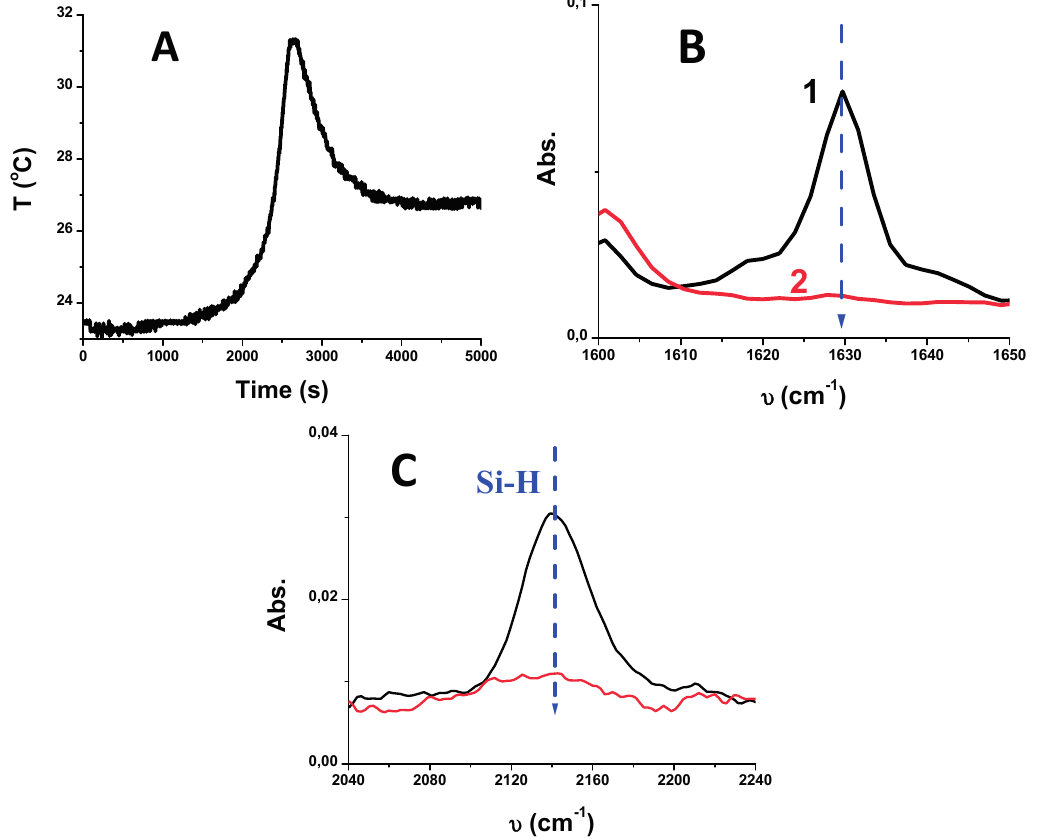
Figure 3. ( A ) Role of the monomer in the thermal free radical polymerization of Styrene (St) under air in the presence of DPSi/NVK/AgSbF 6 (2%/2%/1% w/w ); ( B ) real-time FT-IR spectra in the 1600–1650 cm − 1 wavenumber range of sample containing 1% (wt) of AgSbF 6 , 2% (wt) of NVK and 2% (wt) of DPSi in Styrene under air ( 1 ) before and (2 ) after polymerization; and ( C ) IR band of the decreasing of the DPSi recorded during the